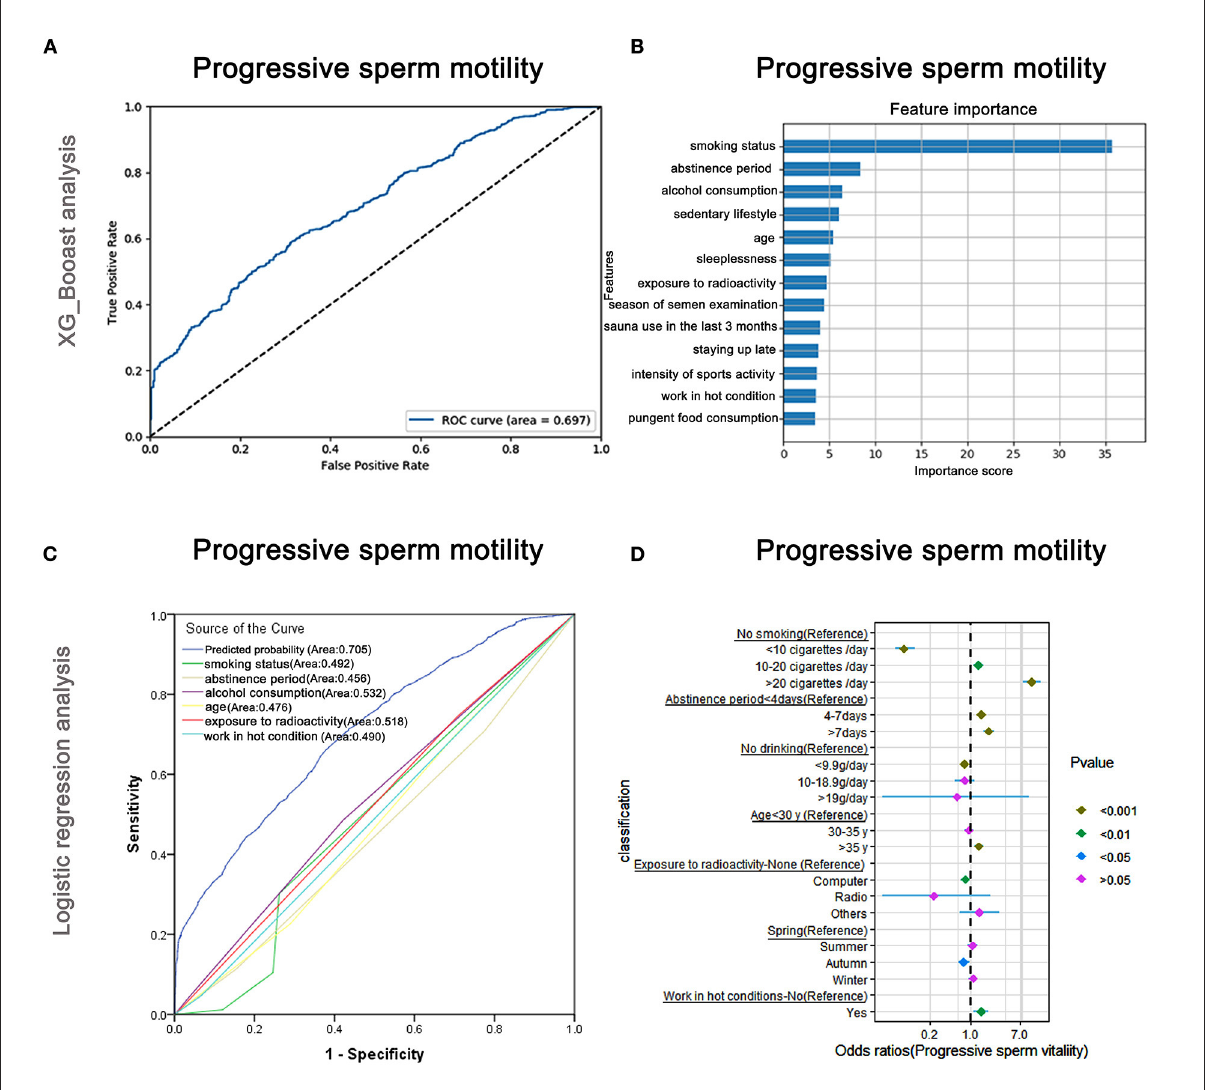
FIGURE5 XGBoost and logistic regression analysis of the risk factors for progressive sperm motility. The ROC curve (A) and the feature importance (B) analyzed by XGBoost and the ROC curves (C) and forest diagram showing significant risk factors (D) analyzed by logistic regression.